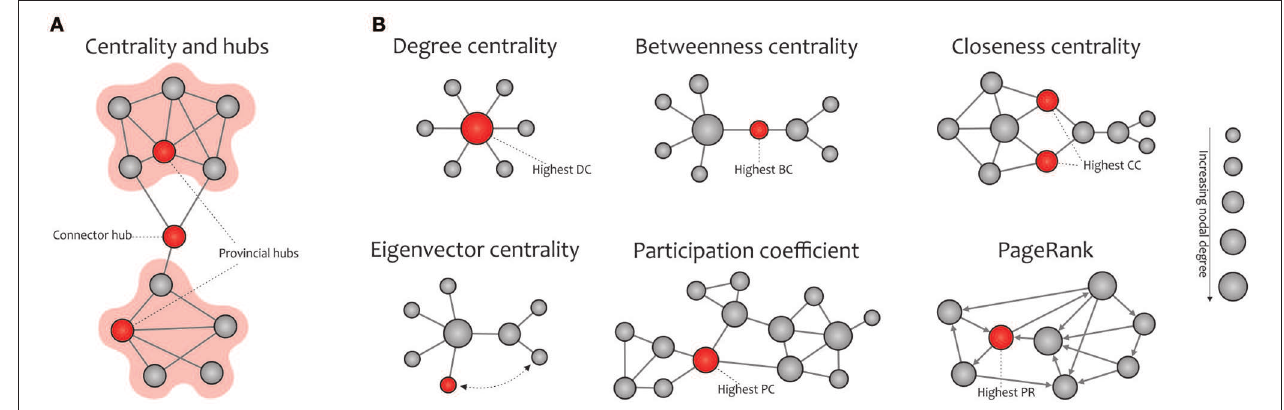
FIGURE 5 | Basic concept of network centralities. (A) Hubs (connector or provincial) refer to nodes with a high nodal centrality, which can be identified using different measures. (B) The degree centrality is defined as the number of node’s neighbors. The betweenness centrality measures the node’s role in acting as a bridge between separate clusters by computing the ratio of all shortest paths in the network that contain a given node. The closeness centrality quantifies how fast a given node in a connected graph can access all other nodes, hence the more central a node is, the closer it is to all other nodes. The eigenvector centrality is a self-referential measure of centrality that considers the quality of a link, so that being connected to a central node increases one’s centrality in turn; the red colored node is more central than the gray colored node, although their degrees are equal. The participation coefficient of a node represents the distribution of its connections among separate modules. PageRank is a variant of eigenvector centrality, used by Google Search to determine a page’s importance; the PageRank of an undirected graph is statistically similar to the degree centrality, but they are generally distinct. Note that the size of the nodes in all cases is proportional to the node degree, and the red nodes (except in the eigenvalue centrality) are the most central with respect to the corresponding definition of centrality, even though their degree are low.